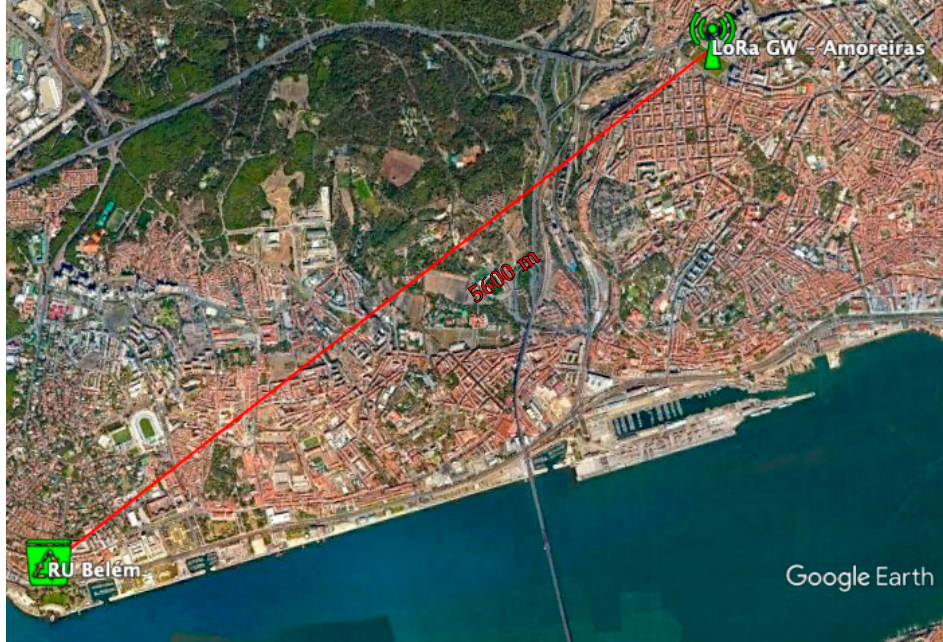
Figure 10. Map showing the distance from the sensor to the LoRa Gateway at Amoreiras.